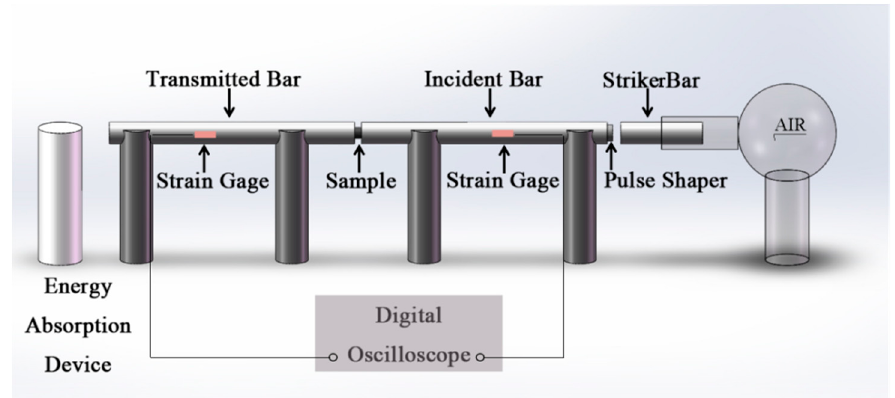
Figure 4. Schematic illustration of the split-Hopkinson pressure bar (SHPB) facility.